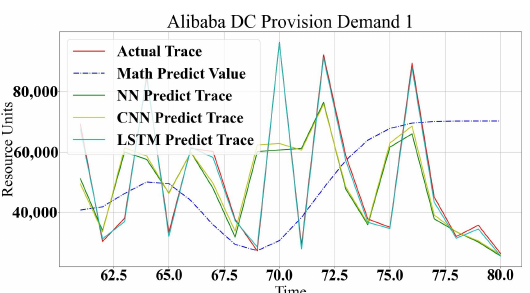
Figure 14. Alibaba Workload Type 1.